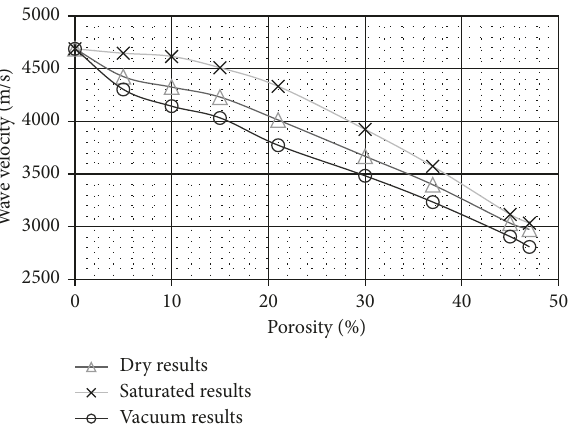
Figure 3: Variation of wave velocity with porosity based on fully saturated, fully dry, and vacuum